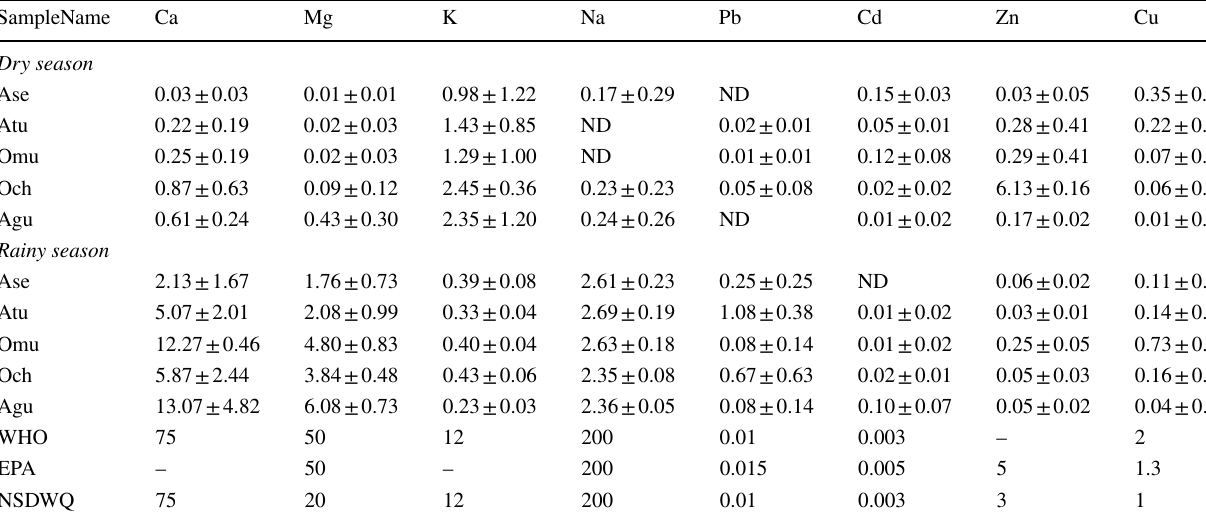
Table 4 Mean Concentration of Mineral Elements and Trace Metals in the Spring Water (mg/L)